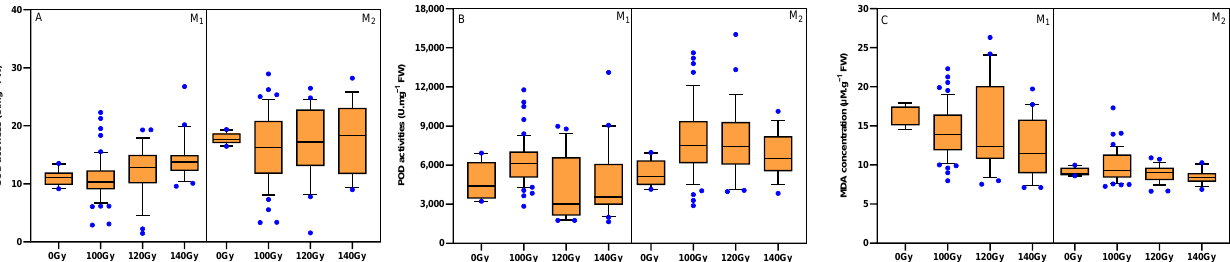
Figure 7. Effects of different radiation doses on antioxidant enzyme activities and MDA concentrations in the M 1 and M 2 generations. ( A ) SOD activities; ( B ) POD activities; ( C ) MDA concentration.